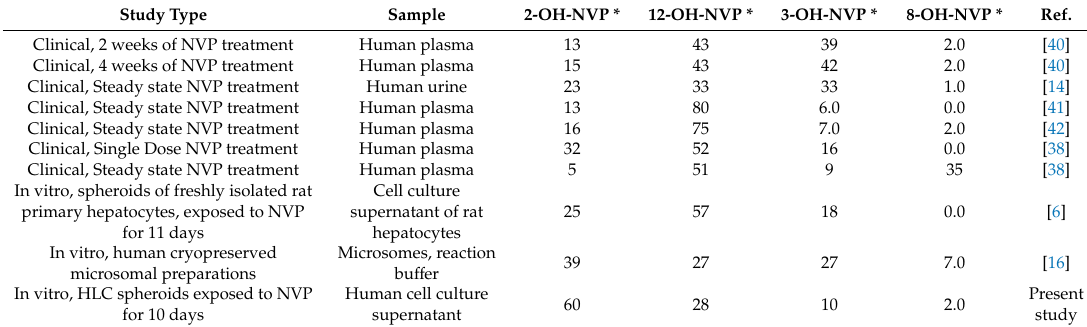
Table 2. Comparison of relative levels (expressed as percentage) of NVP metabolites in clinical, pre-clinical and in vitro